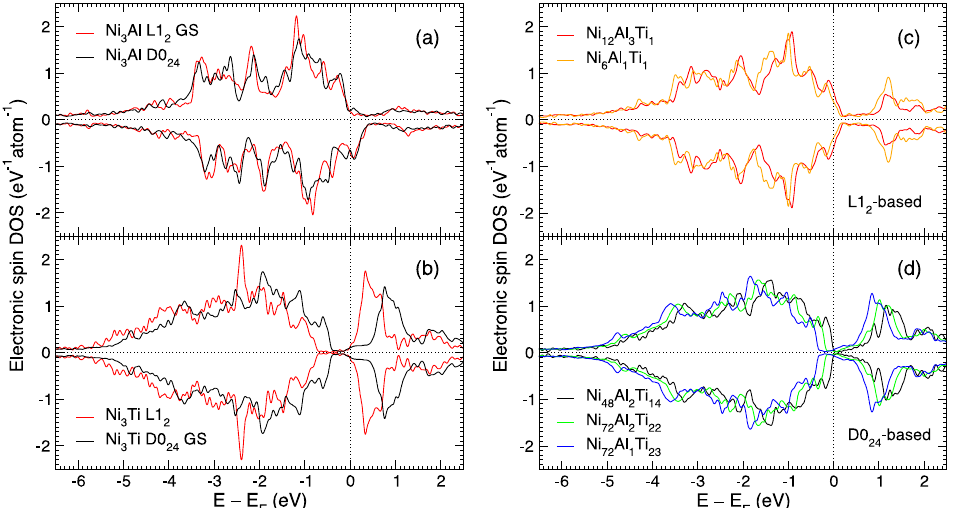
Figure 4. Ni atomic magnetic moment (Bohr magnetons, μ B /atom) versus Ti concentration x in three phases of Ni 3 (Al 1 − x Ti x ) alloys with a homogeneous atomic disorder on the Al/Ti sublattice. Lines are 6 th degree x ( M Ni ) polynomials with even powers, fitted to DFT data points. Inset: 0.0005 e - /Å 3 iso- surfaces of electronic spin density in cubic L1 2 Ni 3 Al unit cell with Ni (grey) and Al (black) atoms.